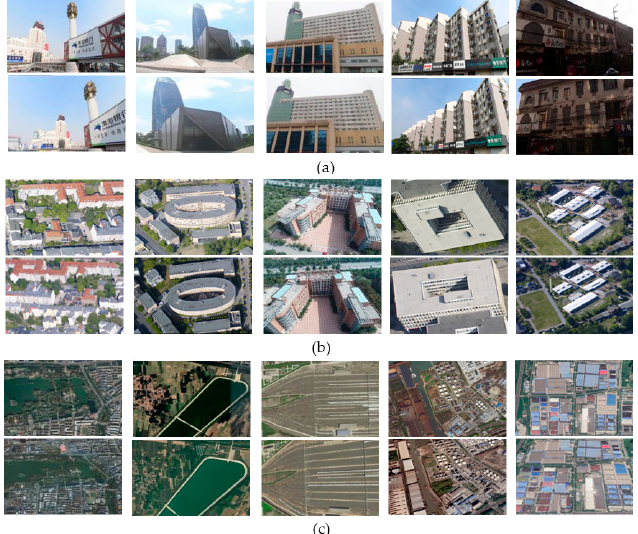
Figure 2. Thumbnail of partial, wide-baseline oblique stereo images from ground close-range ( a ), airborne ( b ), and space platforms ( c ). 2.2. Extraction of Quasi-Dense Conjugate Points Using Complementary Features